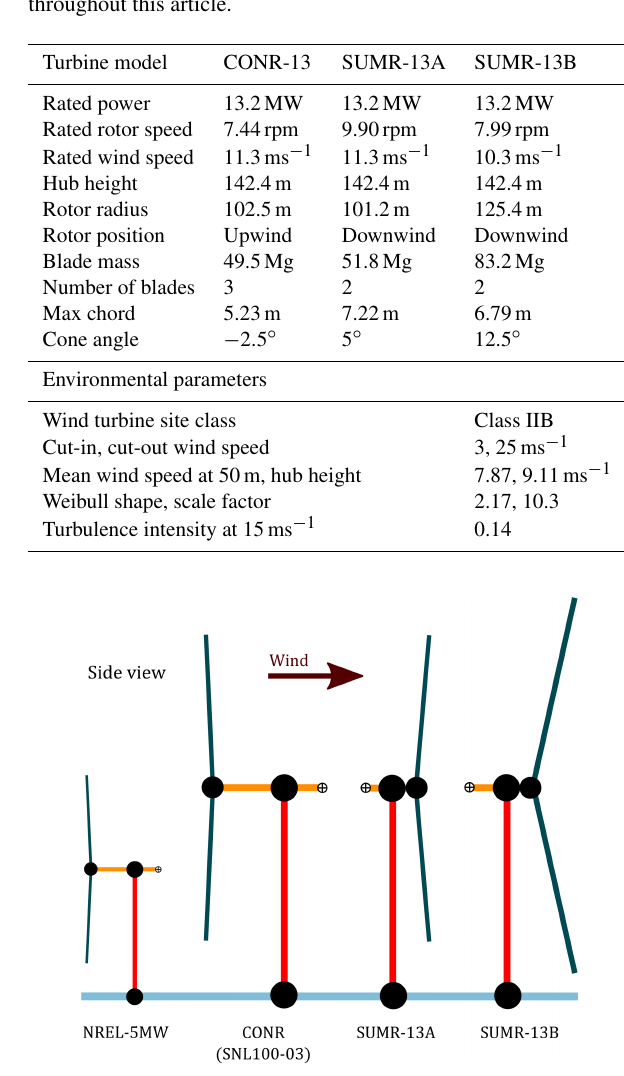
Figure 1. Illustrations of the turbines in this study, along with the National Renewable Energy Laboratory (NREL) 5MW reference turbine (Jonkman et al., 2009) for comparison. Tower heights, rotor radii, and cone angles are drawn to scale; overhangs and nacelle center of masses are enlarged for